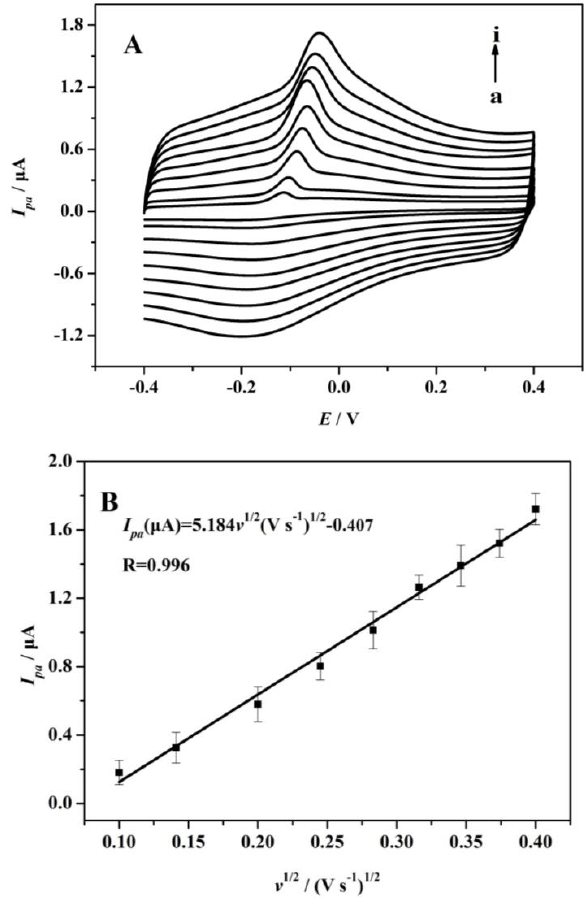
Figure 9. ( A ) Cyclic voltammograms of 1.0 × 10 −2 mol·L −1 AA at PME with various sweep rates: (a–i) 0.01, 0.02, 0.04, 0.06, 0.08, 0.10, 0.12, 0.14, 0.16 V·s −1 ; ( B ) Plot of AA’s I pa versus v 1/2 .Each point represents